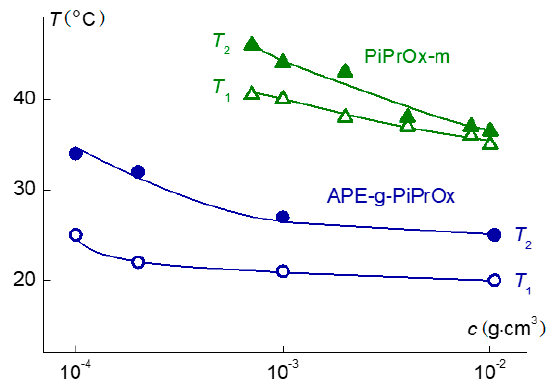
Figure 12. Concentration dependences of temperatures T 1 and T 2 for solutions of grafted copolymer APE-g-PiPrOx and model linear PiPrOx-m.